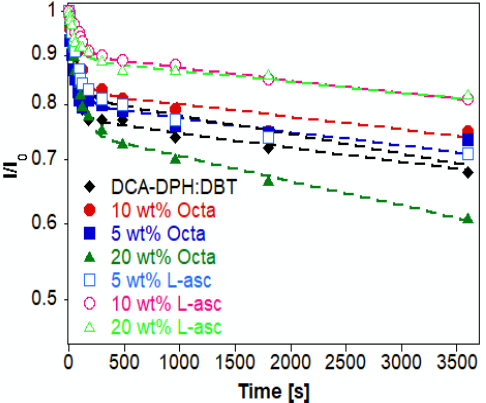
Figure 5. PL emission intensity ratios of bare DCA-DPH:DBT (full black square) and DCA-DPH:DBT with 5 wt.% (full blue square), 10 wt.% (full red circle) and 20 wt.% (full green triangle) of Octa and with 5 wt.% (empty black diamond), 10 wt.% (solid pink triangle) and 20% (empty square) of L-Asc as a function of UV light exposition. Dotted lines are bi-exponential fits (see Table 1).